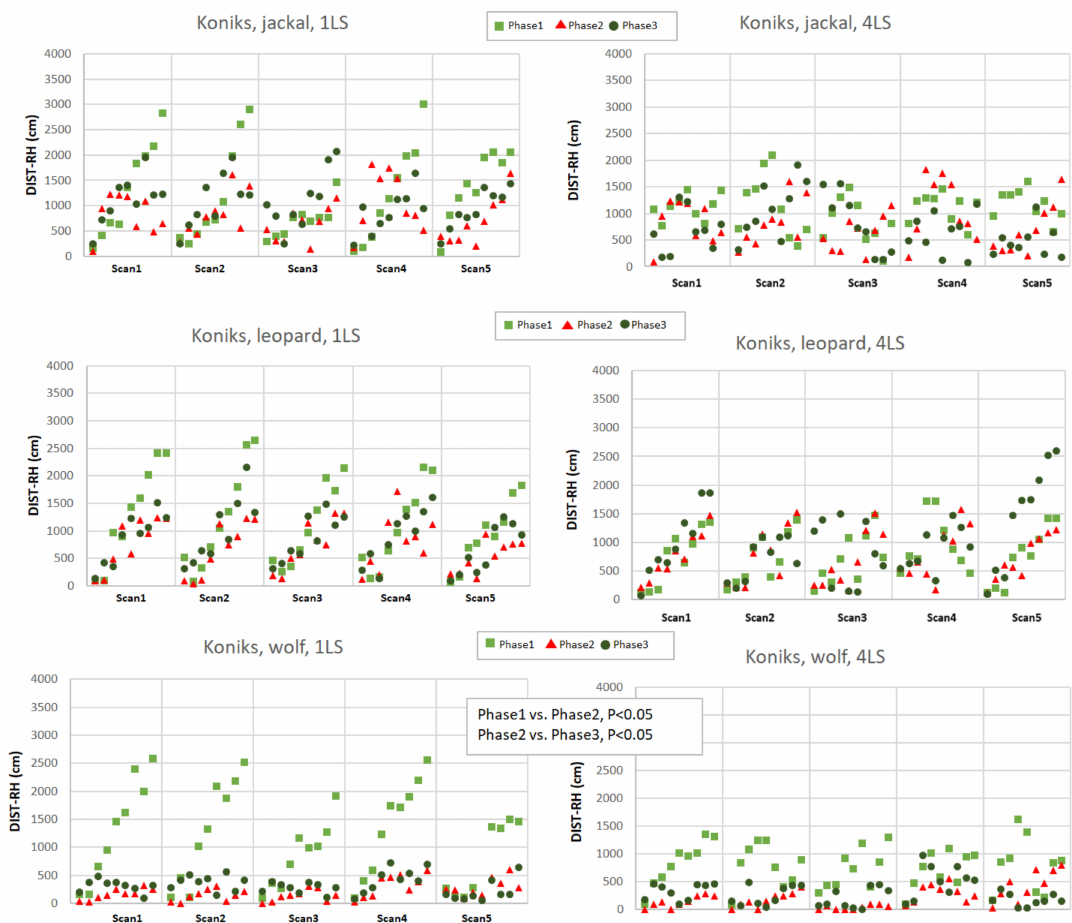
Figure A2. Distance to the reference horse (DIST-RH, cm) in Koniks in response to jackal’s, leopard’s and wolf’s vocalisation played from 1LS and 4LS in pre-, playback and post-playback phases. Each point represents the distance of individual horse from the RH. Phases are depicted with light green squares (phase 1, pre-playback), red triangles (phase 2, playback) and dark green circles (phase 3, post-playback). Only significant di ff erences between phases were shown in the